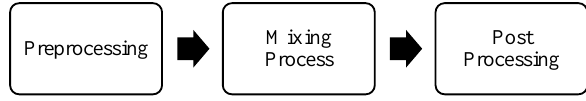
Figure 3: Homogenous Dispersion Process Strategy